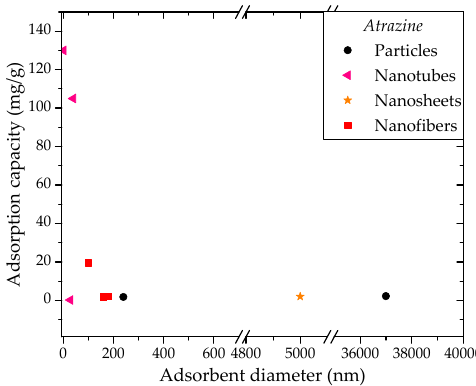
Figure 2. Adsorption capacity (mg/g) related to the adsorbent diameter against Atrazine.